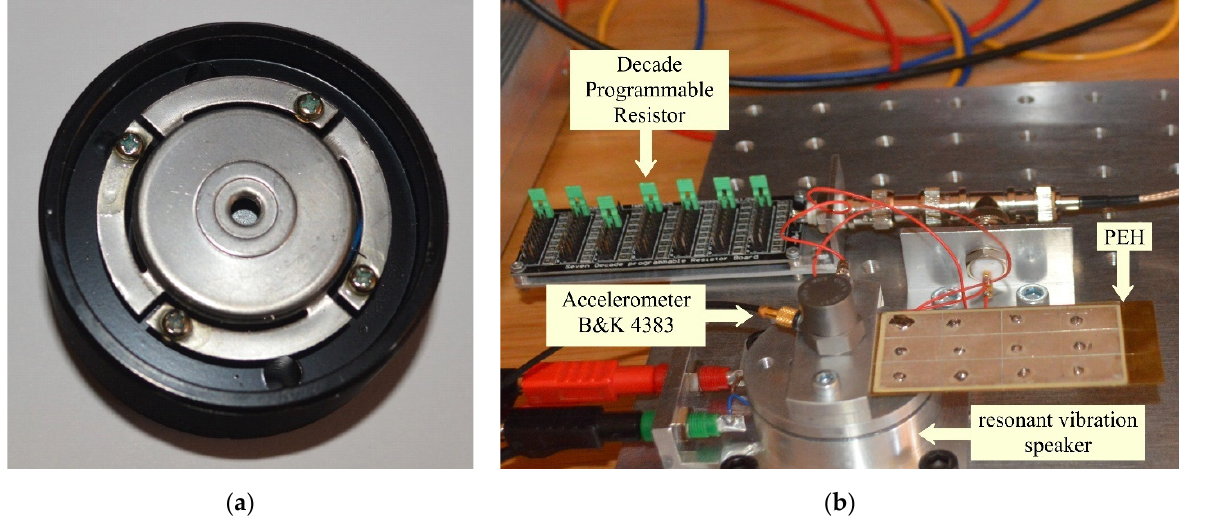
Figure 3. Mechanical setup: ( a ) the resonant vibration speaker; ( b ) the mechanical setup assembled with PEH prepared for measuring the output power map.